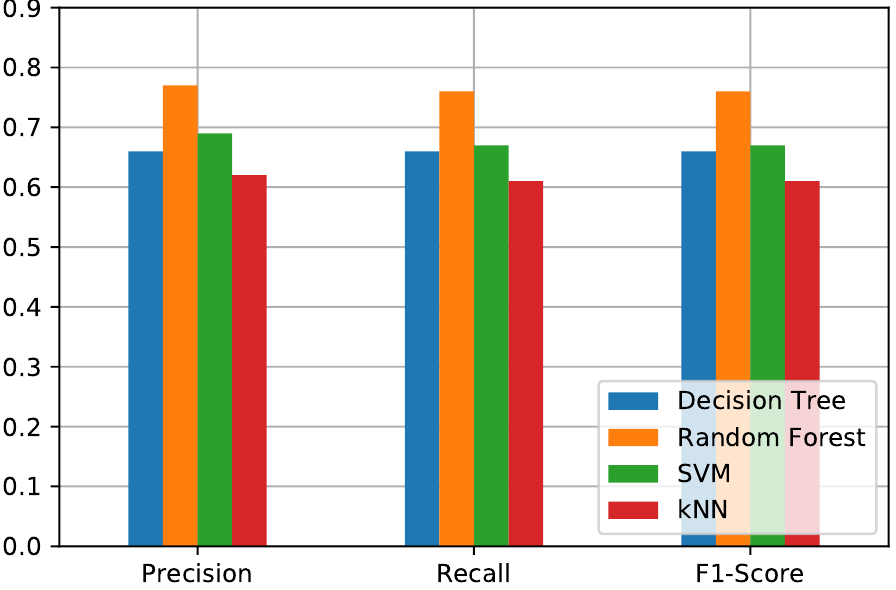
Figure 9. Q1—Precision, Recall, and F1-Score to predict the number of